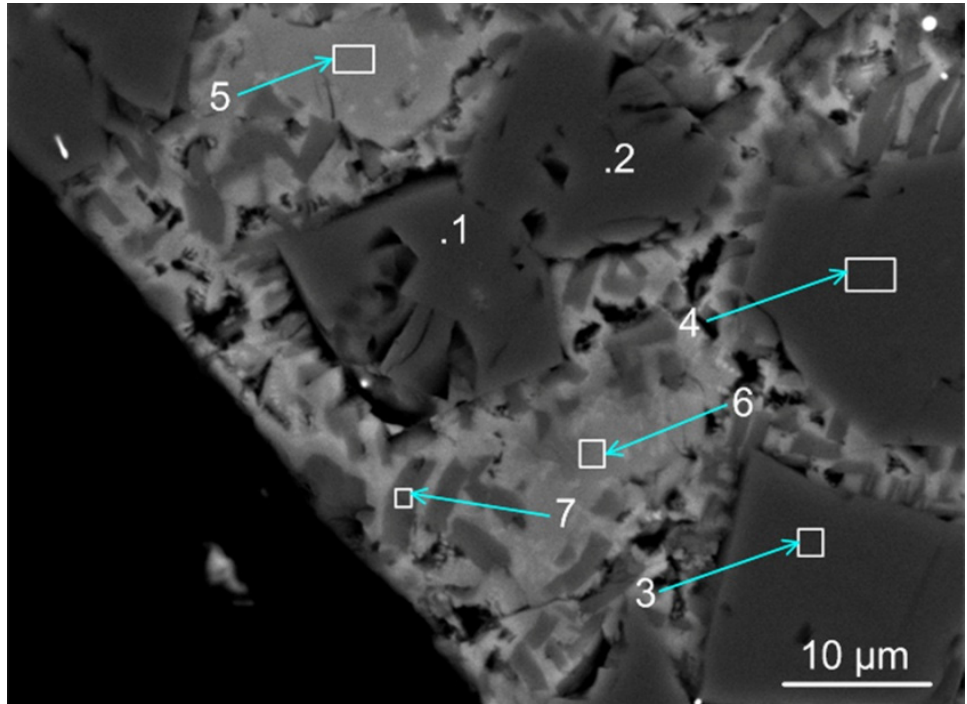
Figure 2. BSE image of the slag area at the slag–weld metal interface: BC slag sample. (See Table 4 for the analyses of the numbered phases in Figure 2). Table 4. SEM analyses of marked phase positions in Figure 2 (mass%).